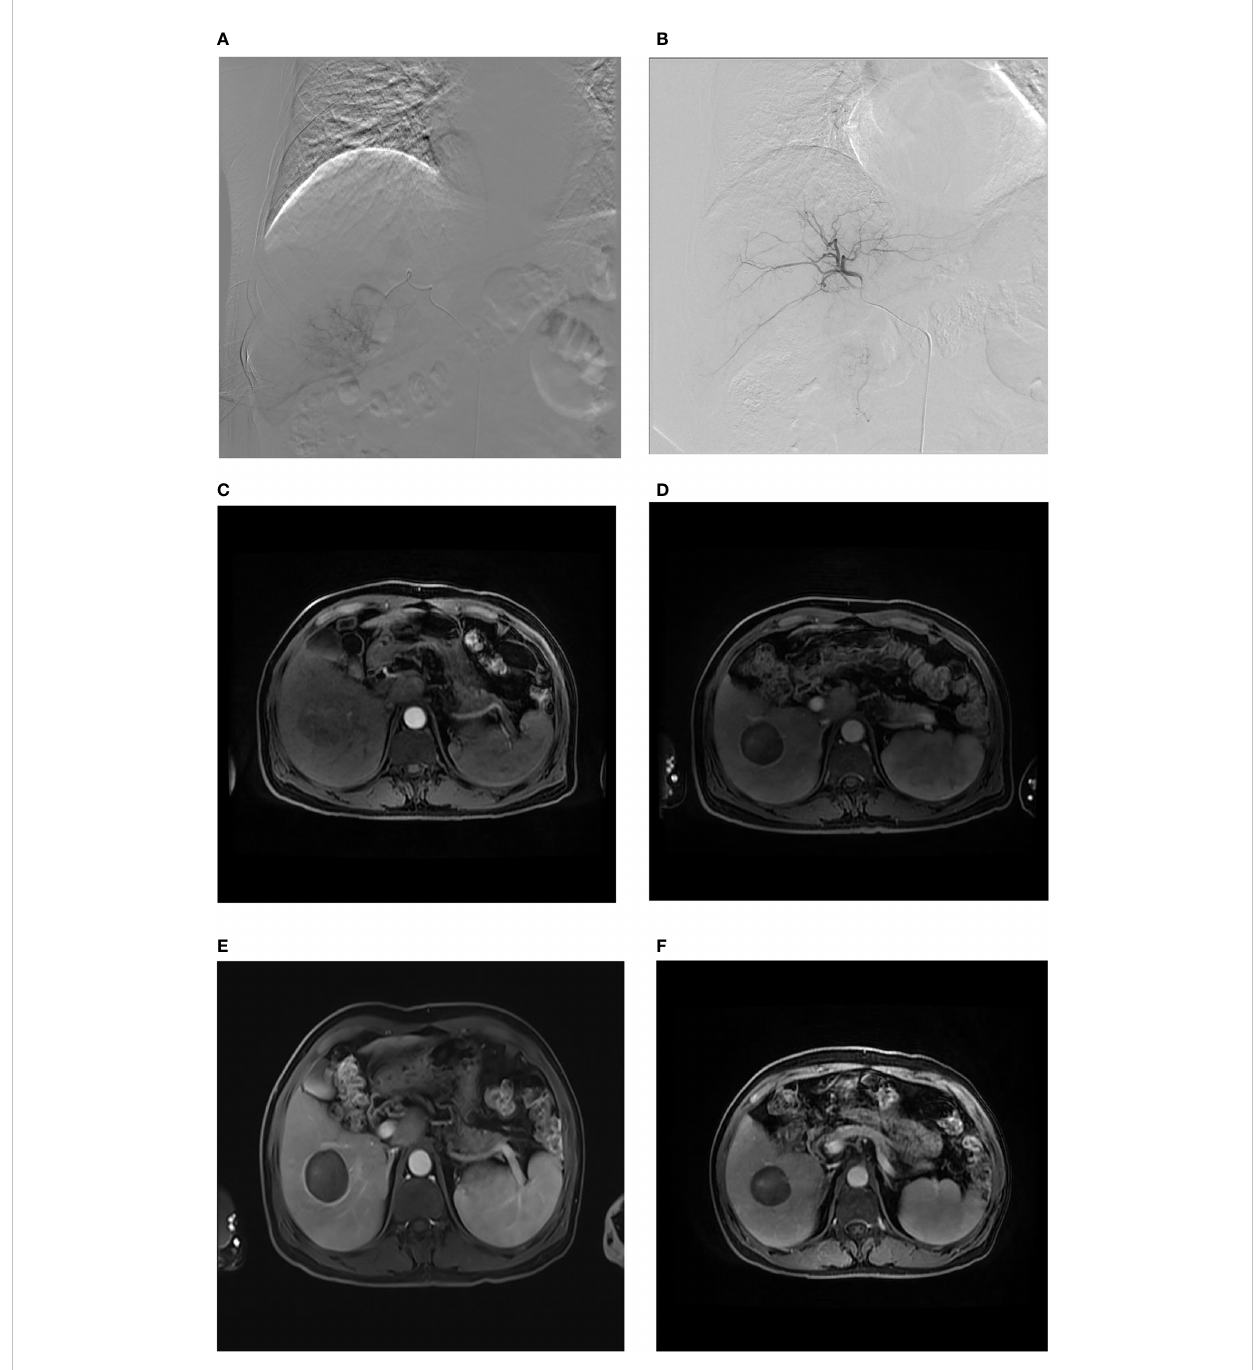
FIGURE 2 Sharp-type tumor margins observed on an axial MR image. A male patient, aged 61 years, was admitted to our hospital due to the detection of liver lesions in the right lobe of the liver during physical examination. (A) When DEB-TACE was administered for the fi rst time, superselective catheterization was performed in the tumor feeding artery, and arteriography demonstrated abnormal focal hyperchromatism at the arterial phase, presenting the “ holding ball sign ” (white arrow); (B) abnormal staining disappeared, as observed through contrast reexamination after the fi rst administration of DEB-TACE; (C) as expected, nonhomogeneous enhancement of HCC was indicated at the arterial phase (white arrow). (D) One month after the fi rst administration of DEB-TACE, sharp-type peritumoral rim enhancement (black arrow) appeared at the delayed phase and at the beginning of the follow-up. (E) Three months after the start of the follow-up period, clear sharp-type peritumoral rim enhancement (black arrow) appeared at the delayed phase. (F) Twelve months after the start of the follow-up, the sharp-type peritumoral rim enhancement (black arrow) still existed, but the enhancement was lighter than that in (E)